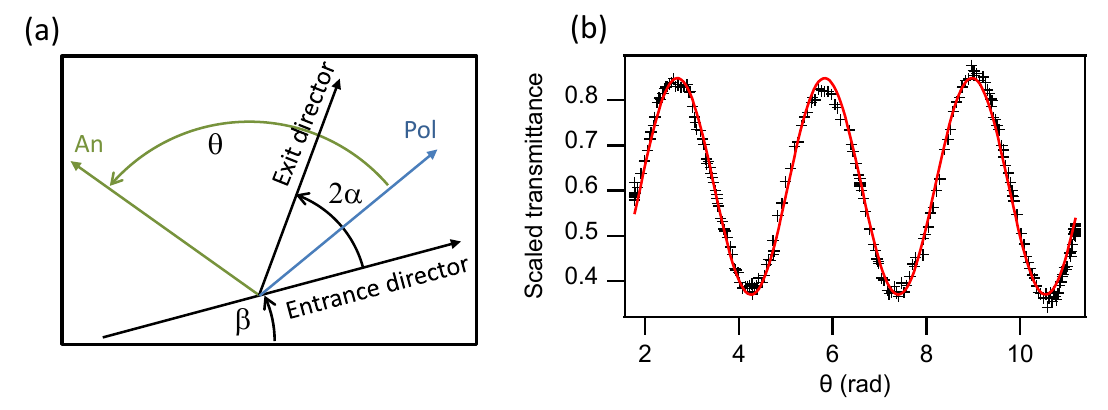
Figure 3. ( a ) Definition of angular variables involved in the analysis of light transmittance through the liquid crystal. All angles are referred to the orientation of the director field where light enters the sample. ( b ) Transmittance data through the center of a SSY nematic gem in coexistence with the isotropic medium as a function of the angle between analyzer and polarizer when the latter is rotated continuously. The solid line is a fit to the function described in the text for a twisted bipolar director